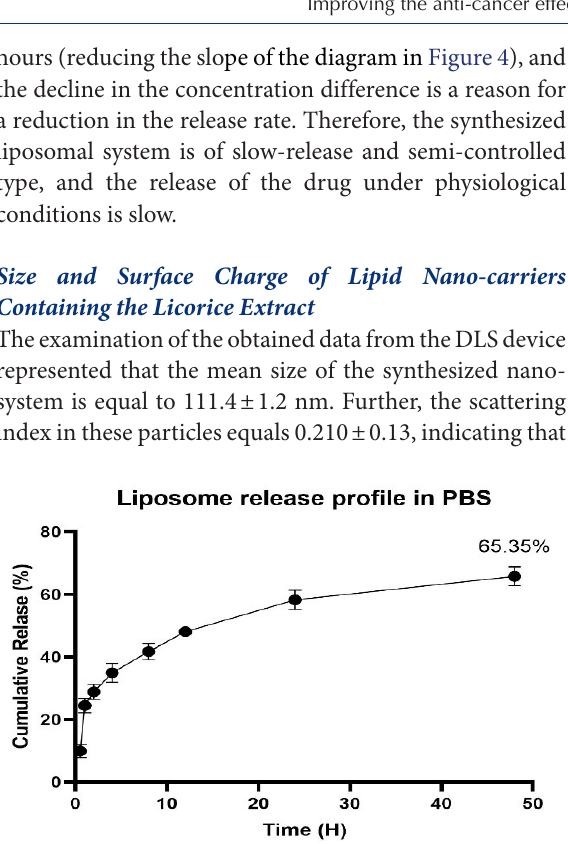
Figure 4. The Release Process of the Licorice Extract From Lipid Nano- carriers Under Physiological Conditions of the Body After 48 Hours. Note. PBS: Phosphate-buffered saline.